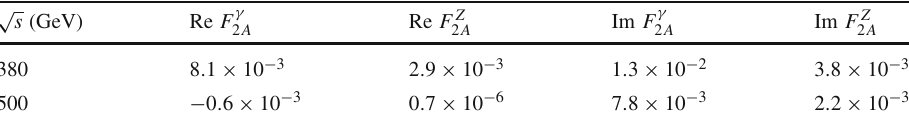
Fig. 1 Left panel: the real part of the top-quark EDF F (dashed, blue), evaluated with the couplings of Table 1 and WDF F Z 2 A and neutral Higgs-bosonmasses m 1 = 125 GeV, m 2 = 1200 GeV, and